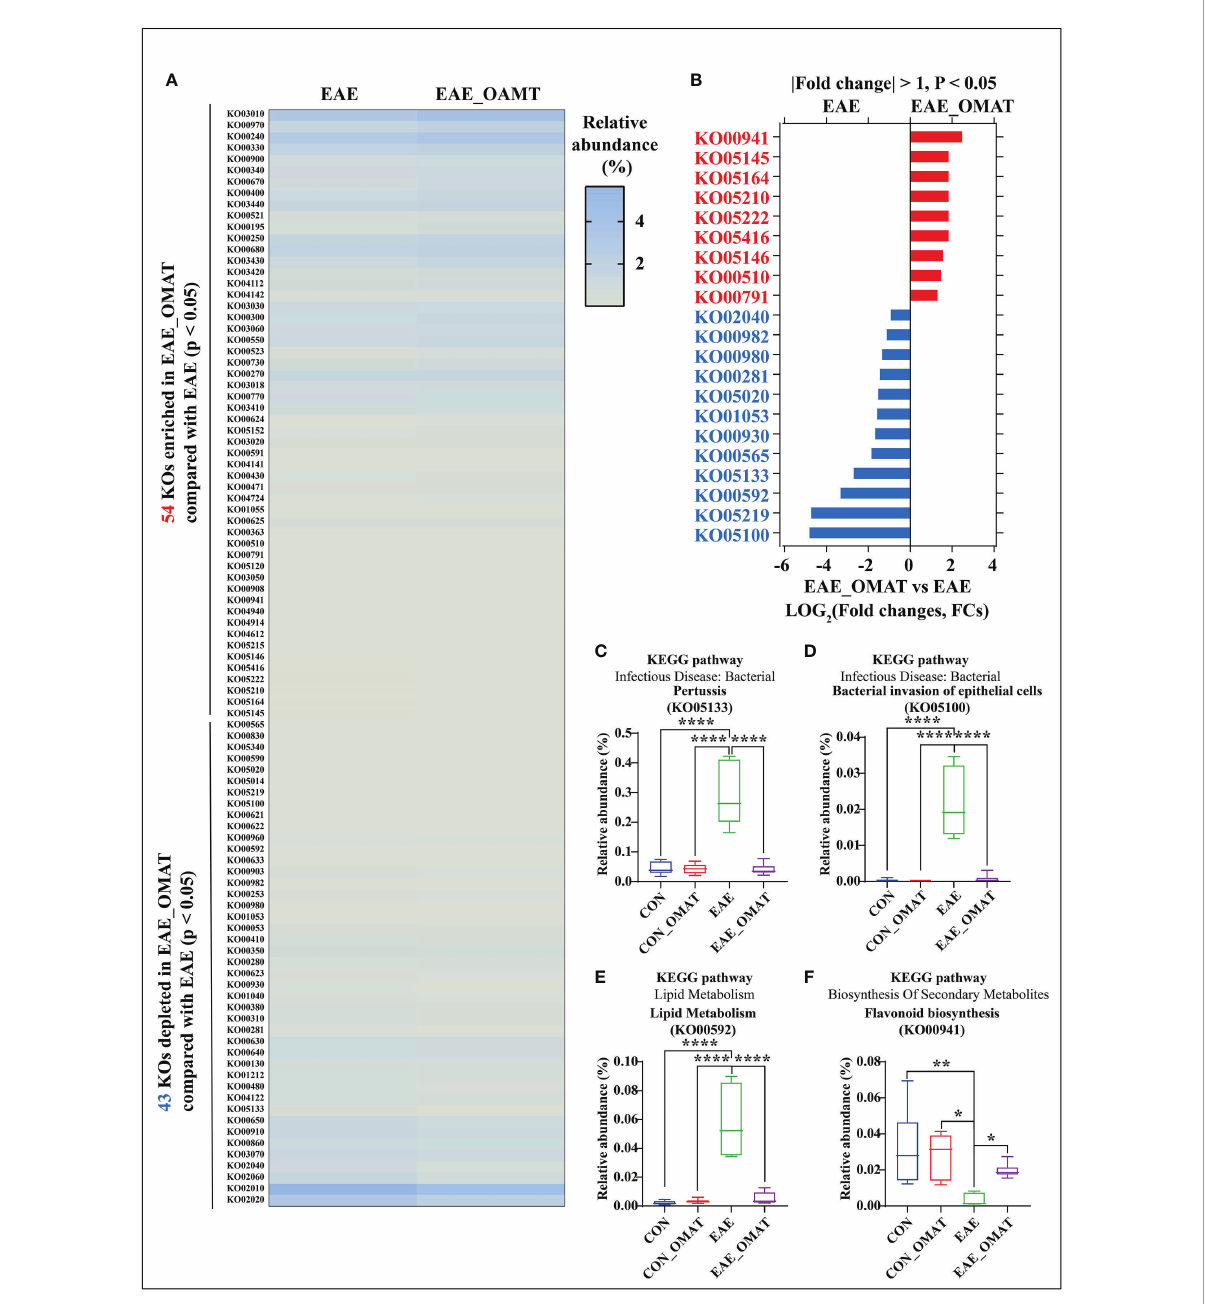
FIGURE 5 Effect of oxymatrine on the functional pro fi ling of the gut microbiome. (A) The list of 54 signi fi cantly enriched and 43 signi fi cantly depleted KEGG ortholog (KOs) in the EAE_OMAT group than in the EAE group ( P < 0.05 ). (B) Ranked based on the fold changes of relative abundance (|LOG 2 (FCs)| ≥ 1), these individual pathways include at least one of the 9 signi fi cantly enriched KOs (EAE_OMAT-enriched KOs) or one of the 12 signi fi cantly depleted KOs (EAE_OMAT-depleted KOs) in the comparisons between the EAE and EAE_OMAT groups. (C – F) Relative abundance of the 4 signi fi cantly enriched or depleted KOs in EAE compared with EAE_OMAT. The relative abundance of pertussis (KO05133; (C) , bacterial invasion of epithelial cells (KO05100; (D) , alpha-Linolenic acid metabolism (KO00592; (E) , fl avonoid biosynthesis (KO00941; (F) between the four subject groups. Data are expressed as the mean ± SD and statistical differences are represented by *, P < 0.05, **, P < 0.01, and ****, P < 0.0001 based on Wilcoxon rank-sum test with the Benjamini – Hochberg method for multiple group